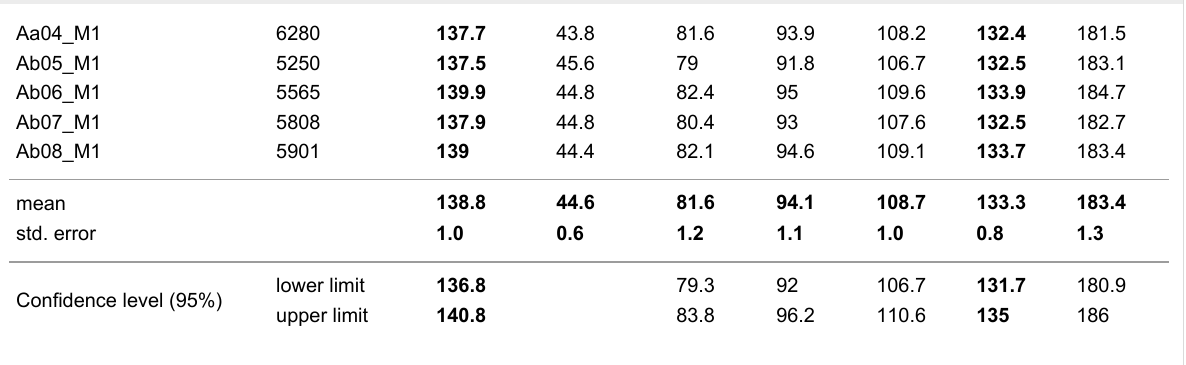
Table 4: Evaluation of the primary particle sizes of KRONOS K1171 in terms of the minimum Feret diameter; all values given in nm. (continued) Aa04_M1